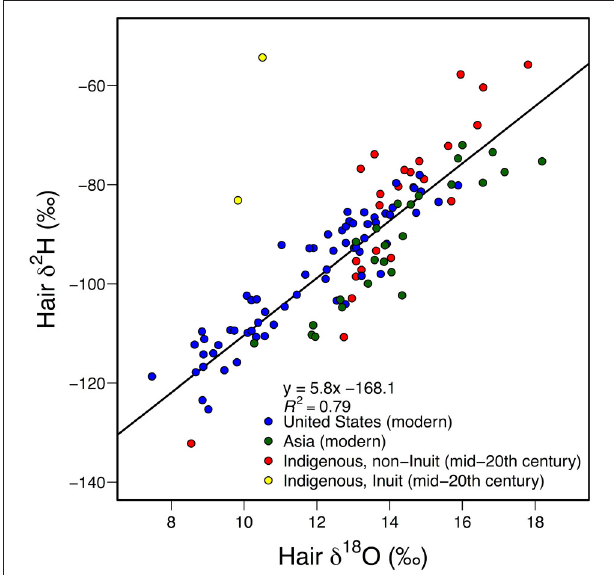
FIGURE 4 | Mean δ 2 H and δ 18 O values measured in human hair samples from modern United States ( n = 66 , Ehleringer et al., 2008) and Asian cities ( n = 25 , Thompson et al., 2010) as well as mid-twentieth century indigenous populations ( n = 26 , Bowen et al., 2009 ). A strong correlation exists between the H and O isotope ratios of these globally distributed samples. Mean values from two Inuit groups with marine-dominated diets were not included in the regression, as the deviation from the relationship defined by the other samples indicates that different mechanisms control the isotopic values under these unique dietary conditions ( Bowen et al.,